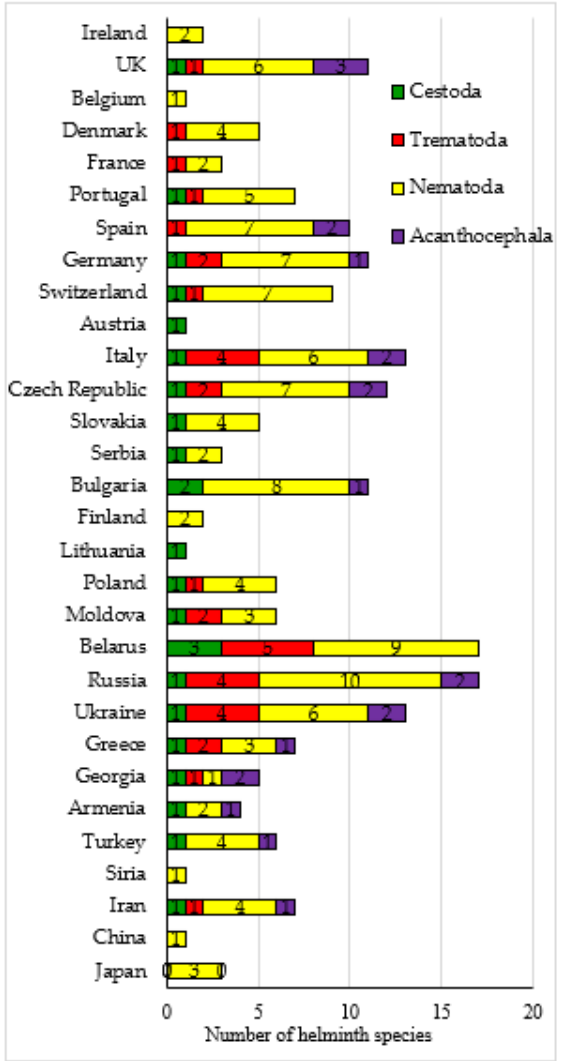
Figure 1. Species richness of helminths in hedgehogs of Erinaceus genus in Palaearctic